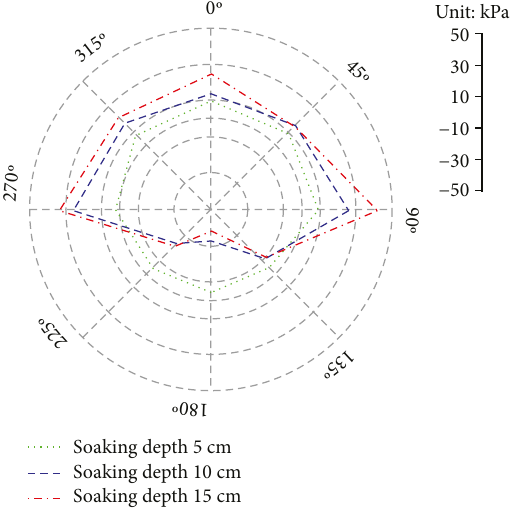
Figure 11: Soil pressure of full-range soaking in fi nal